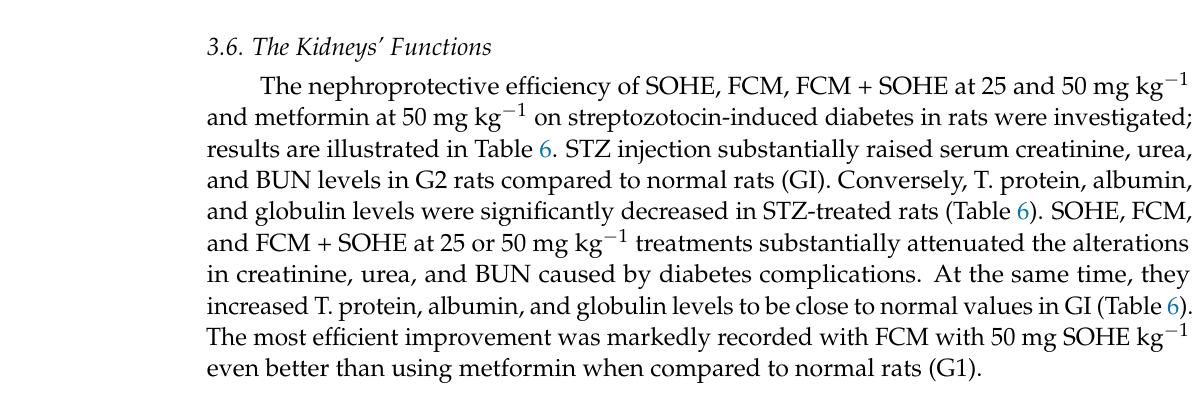
Table 6. Effect of probiotic-enriched FCM combined with S. officinalis on kidneys’ functions in STZ-induced diabetes in